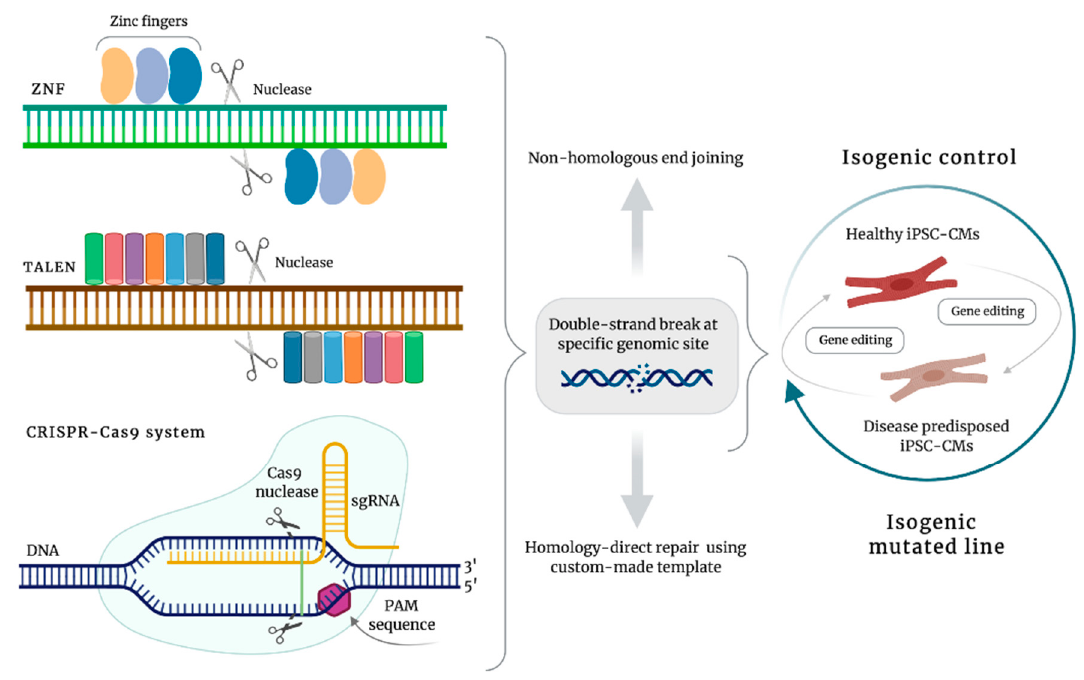
Figure 3. Application of genome-editing tools in human iPSC